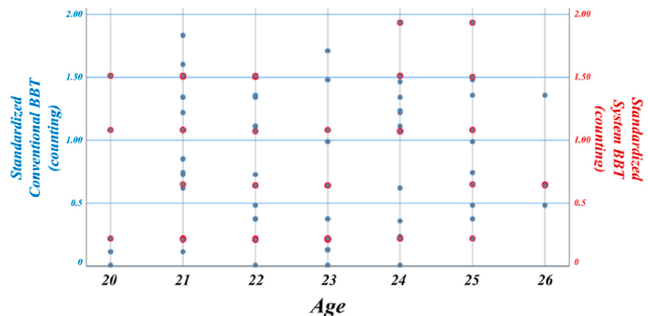
Figure 8. The standardization process in which data of each group are changed to the same size. Since it is difficult to compare each group’s data value, efficient comparison is possible after the Z-score standardization process.